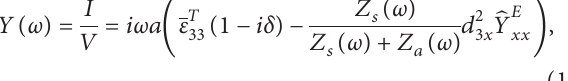
Figure 1: Schematic of the smart